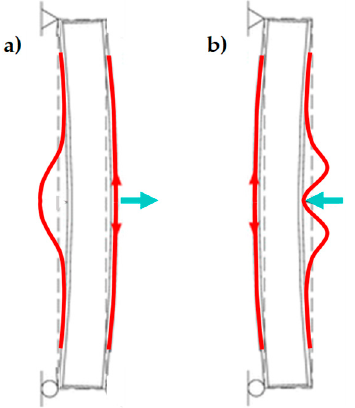
Figure 18. Buckling of the compressed CFRP strip for the two possible positions of the load: ( a ) load applied on the side opposite to that of buckling and ( b ) load applied on the side of buckling, pushing on the compressed CFRP strip.